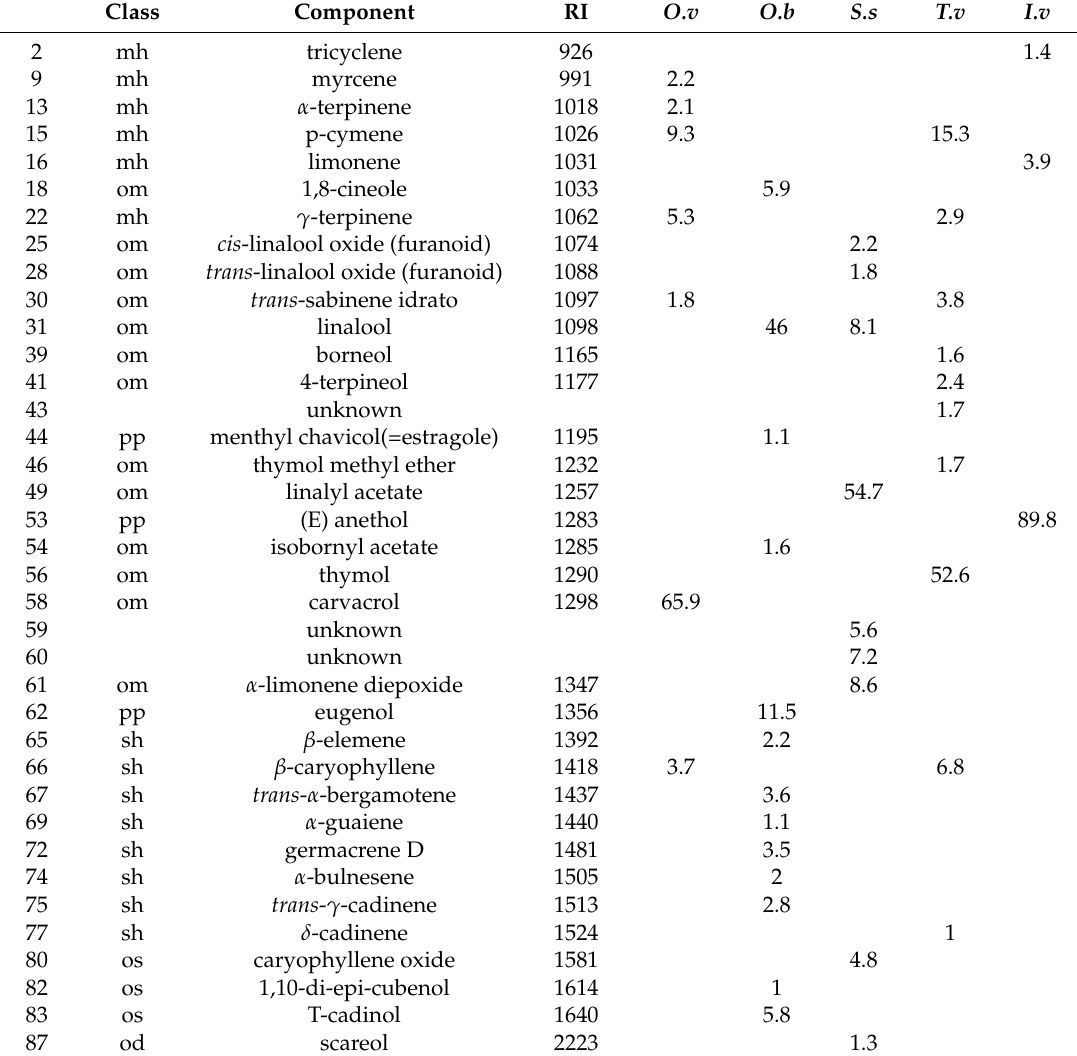
Table 1. Relative percentage of the main constituents of tested essential